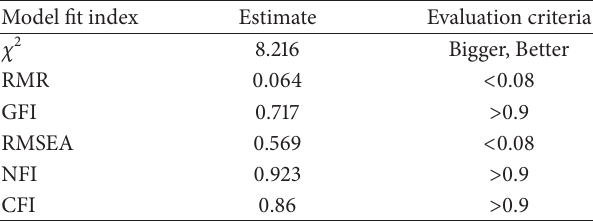
Table 6: Model fit